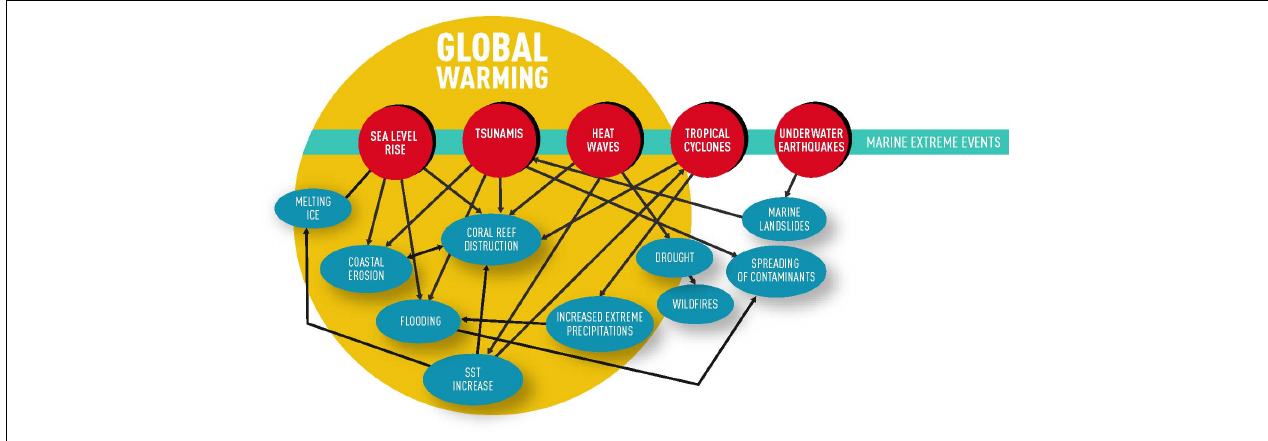
FIGURE 1 | A simplified example of the complexity and multiple interactions of extreme events, showing influences which may generate domino effects . The line of the extreme events embeds only the examples treated in this work, taking into account the potential induced side effects. Global Warming is here represented as a macro category (in yellow) in which different processes contribute to its effects and which, in turn, act as positive feedback enhancing the occurrence of extreme